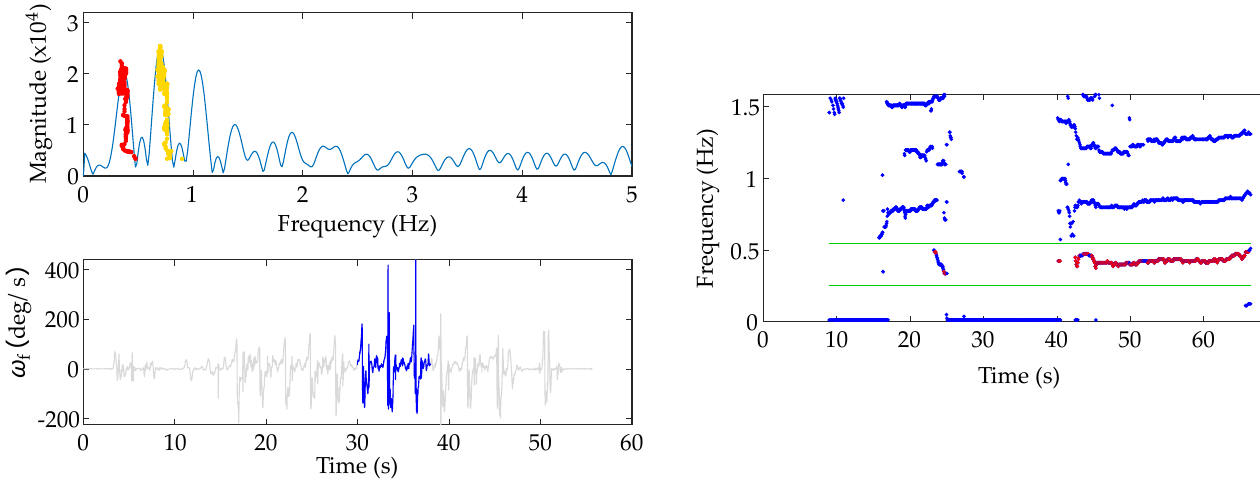
Figure A1. An illustration of the STFT (short-time Fourier transform) implementation in real-time. In the lower left plot, the sagittal plane angular velocity ( ω f ) of the foot is shown in grey. The window of sample used during the snapshot (at around time t = 38s) is highlighted in blue. The upper left plot shows the frequency spectrum corresponding to time t = 38s. The red and yellow dots represent the paths traced over the duration by the peaks corresponding to the first harmonic (stride frequency) and the second harmonic (step frequency), respectively. In the right plot, the time-frequency domain output (of the entire data set) from an offline implementation of STFT is shown in blue dots while the corresponding output from the implementation in real-time (for the first harmonic) is shown in the red dots. Note that the sampling interval is slightly irregular in the real-time implementation due to computational complexity associated with STFT. It can be observed that there is a clear separation between the first, second, and third harmonics (the green lines border the first harmonics, which corresponds to the stride